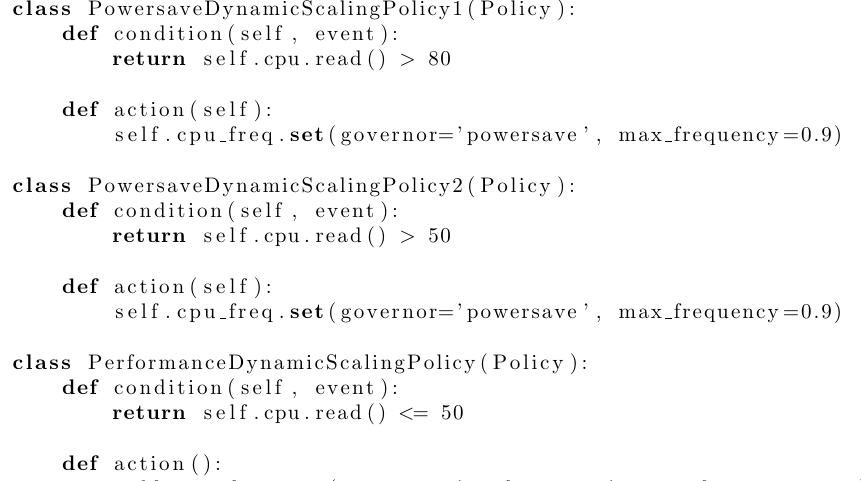
Figure 11. Example of implementation of a reactive policy.